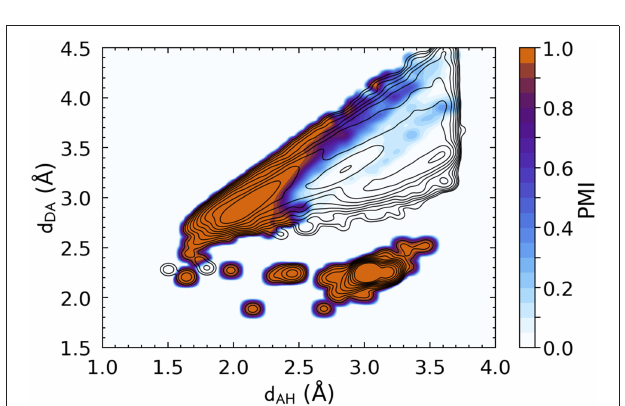
FIGURE 2 | Density plot of the PMI constructed using the DSSP hydrogen bond definition with ζ = 10 − 5 . The PMI is plotted on top of a histogram of the distance features for N − H ··· O hydrogen bonds (discarding non-backbone groups, and any triplet for which it is not possible to define a DSSP H-bond energy, e.g., due to partial occupations), with log-spaced contours. DSSP identifies very clearly the H-bond peak, but also picks up spurious correlations corresponding to immediately adjacent residues [peak at ( d AH ≈ 3.0, d DA ≈